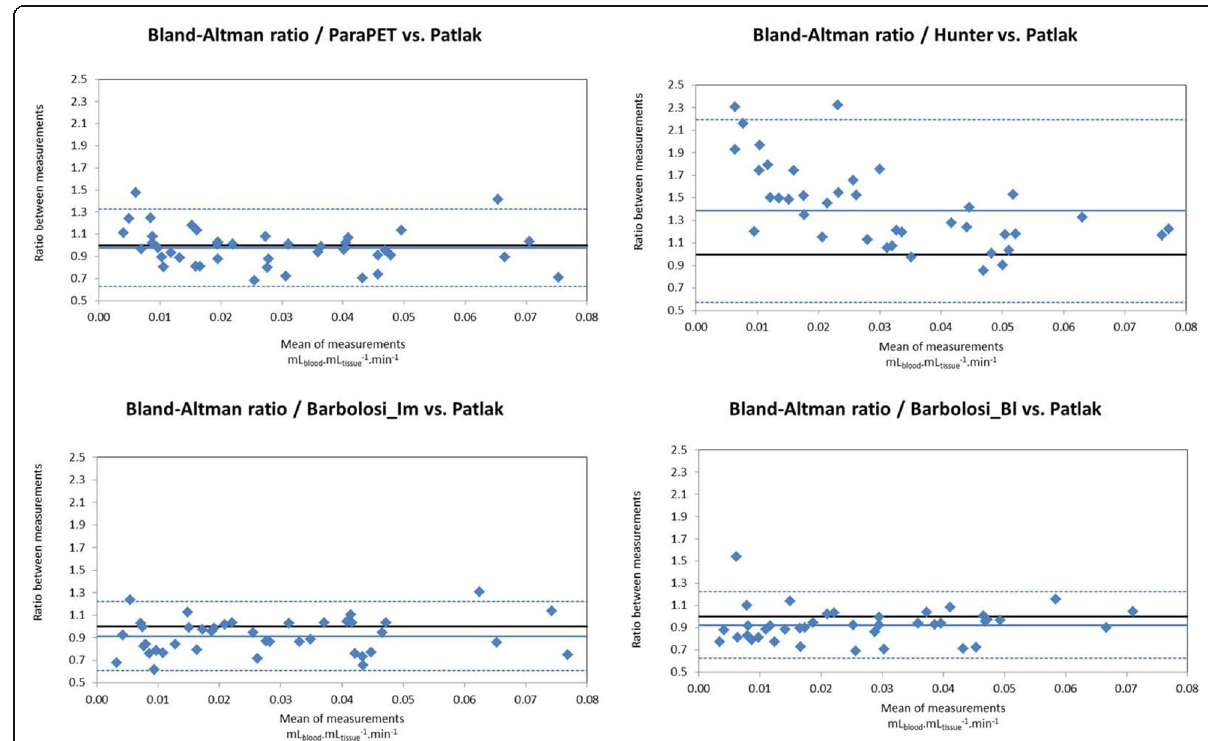
Fig. 5 Bland-Altman ratios between the Patlak K i,max value and K i,max values derived from other approaches. Results for ParaPET (upper left), Hunter ’ s method (upper right), Barbolosi-Im method (bottom left) and Barbolosi-Bl method (bottom right). All these values correspond to the same voxel position. The mean ratio and the 1.96 SD limits are represented by the solid and the dashed lines respectively